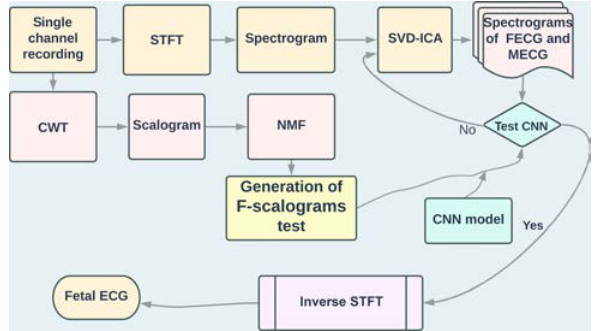
Fig. 2 Mixture signal.